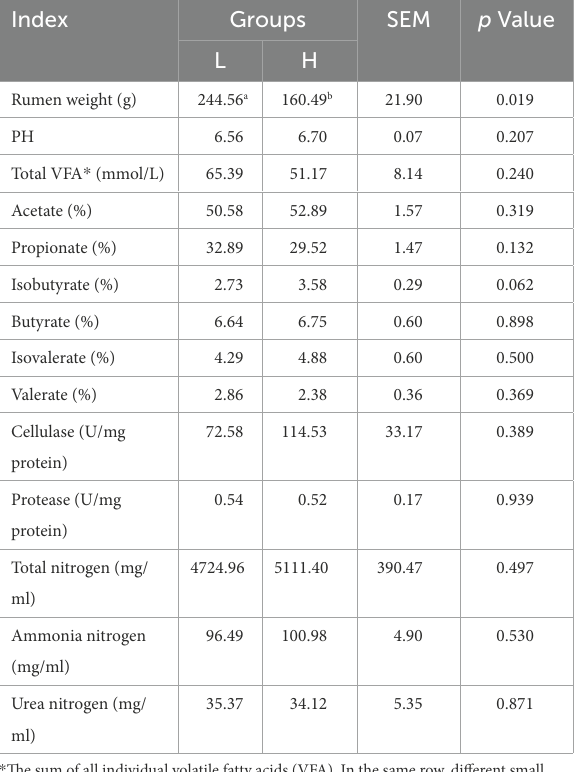
TABLE 3 Effects of MR levels on the rumen weight, pH, fermentation parameters and enzyme activities of lambs.